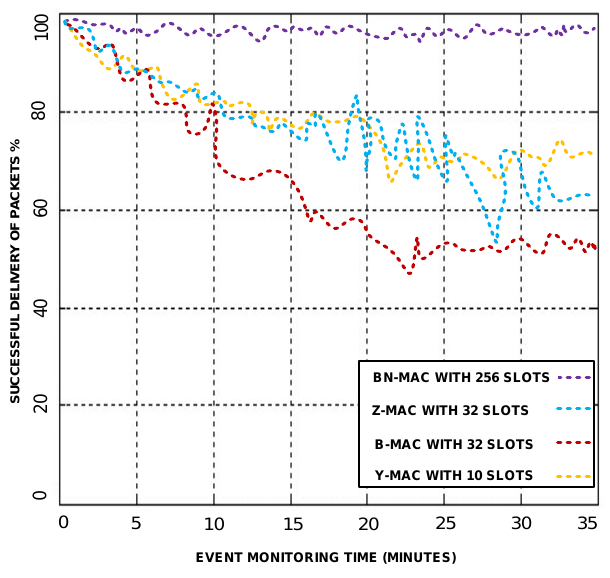
Figure 5. Successful delivery of packets versus event monitoring time.